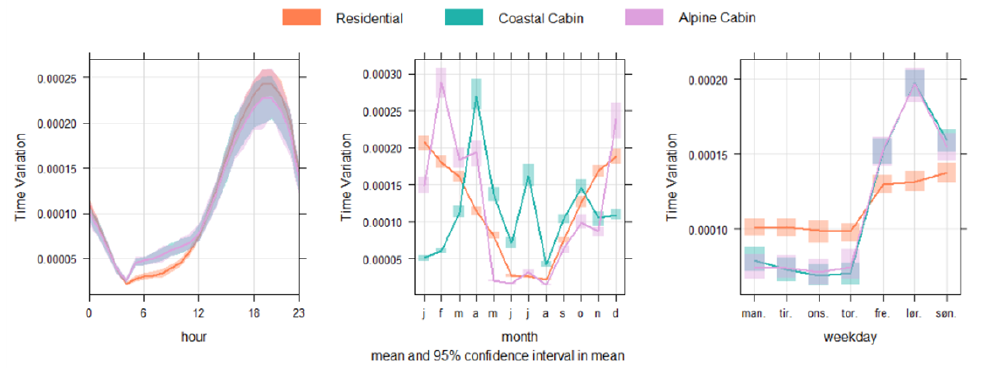
Figure 7. Time variation of emissions from residential and cabins wood combustion. Cabins are shown split in coastal and alpine cabins. Unit: hourly